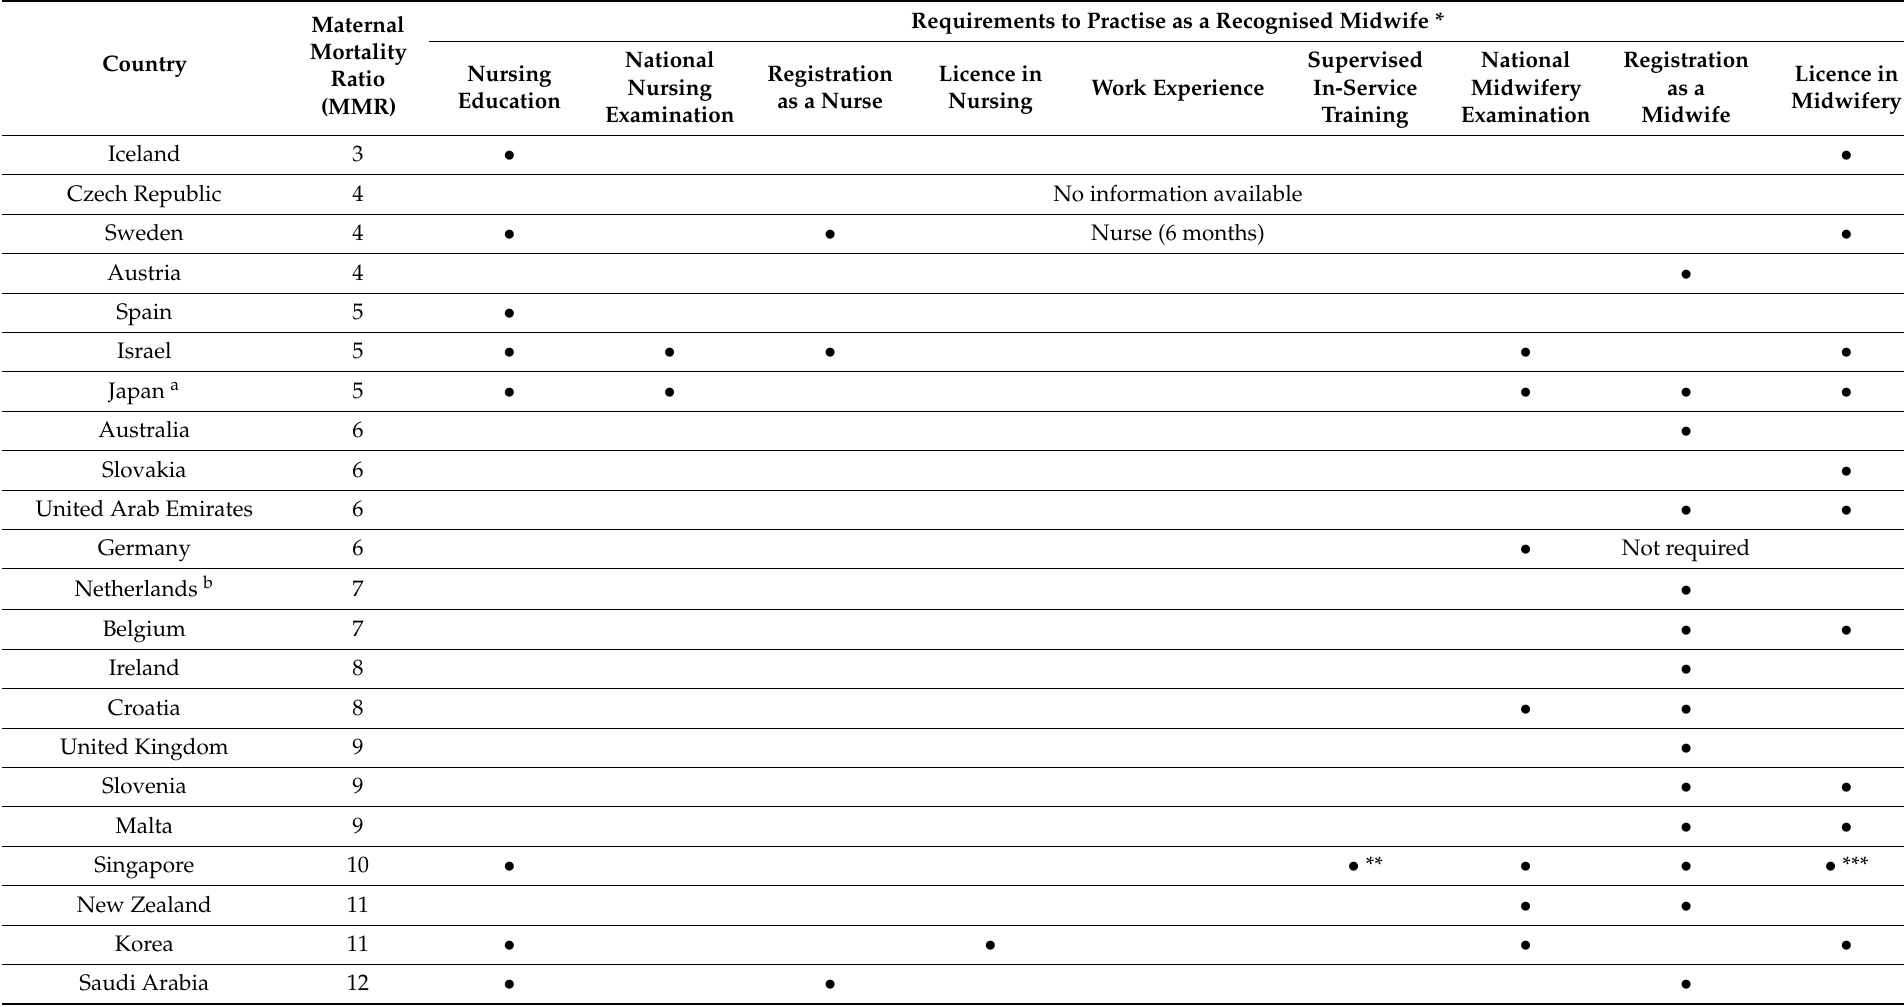
Table 2. Requirements to practise as a